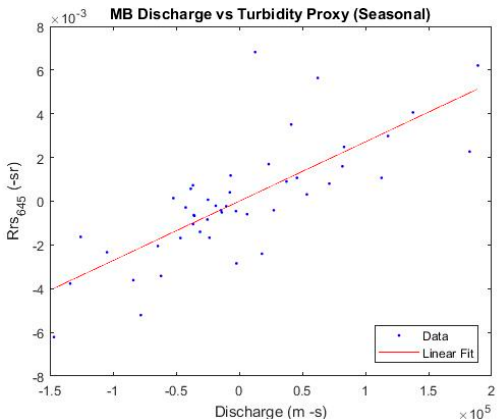
Figure 3. Plot of Mobile Bay seasonal time-series discharge vs. turbidity proxy anomalies (R 2 adj = 0.570, p = 0.001, n = 46).